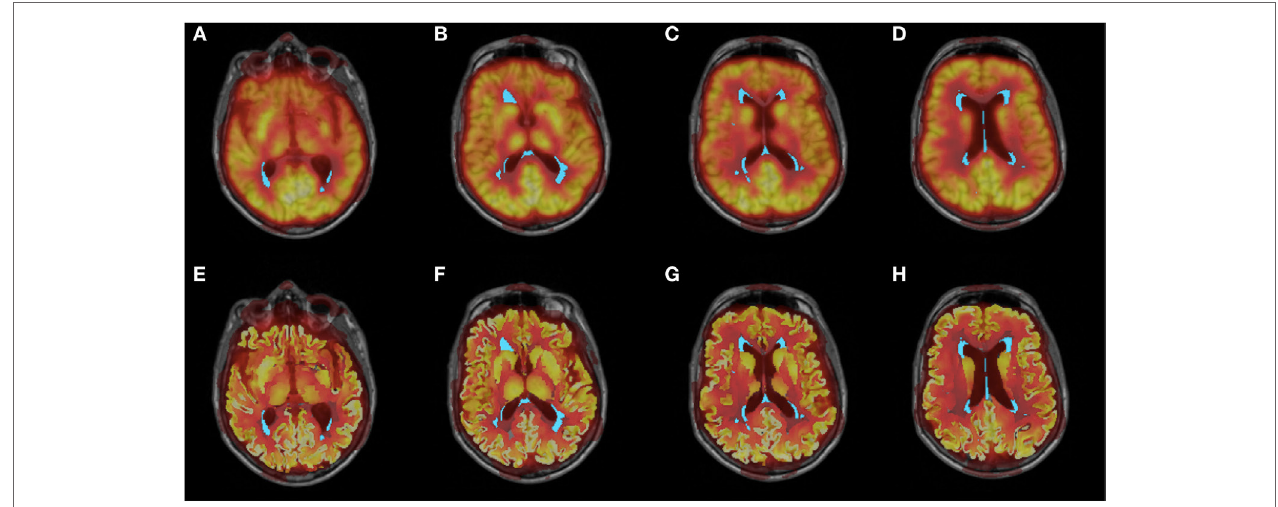
FigUre 2 | co-registered structural Mri, WMh segmentation (cyan), and partial voluming uncorrected (a–D) and corrected (e–h) FDg-PeT images